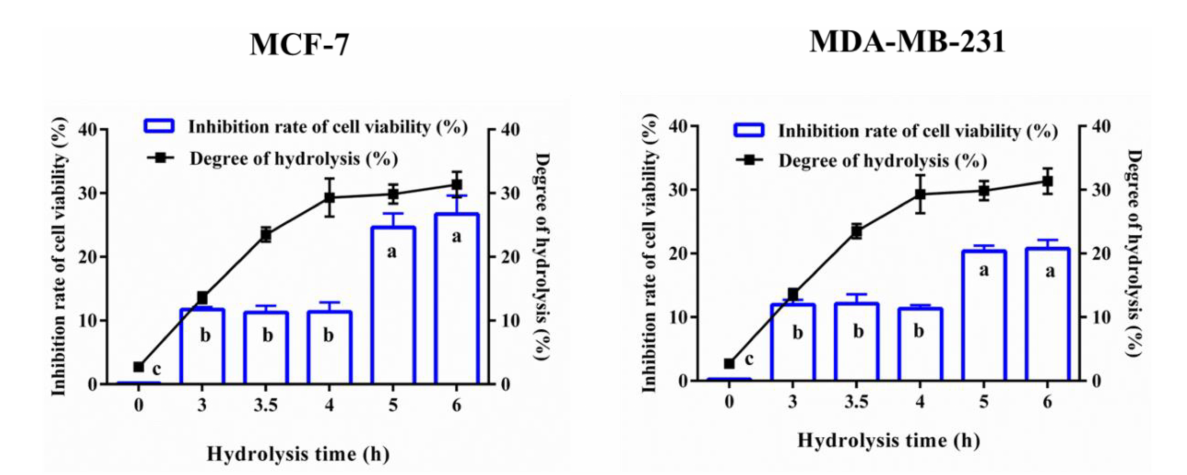
FIGURE1 Anti-breast cancer cells activity and degree of hydrolysis of yak milk casein hydrolysates (YMCH). Yak milk casein (YMC) was united hydrolyzed by trypsin (3 h)+alkaline protease (0–3 h). MCF7 and MDA-MB-231 cells were incubated with the hydrolysates (final assay dose, 0.5 mg/mL) for 48 h, and the inhibitory effects of hydrolysates on the two breast cancer cells were evaluated by